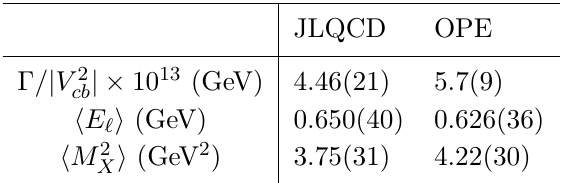
Table 2 . Total width and moments in the JLQCD case.